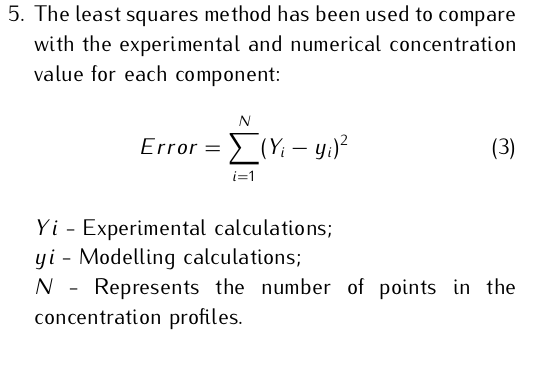
5. The least squares method has been used to compare with the experimental and numerical concentration value for each